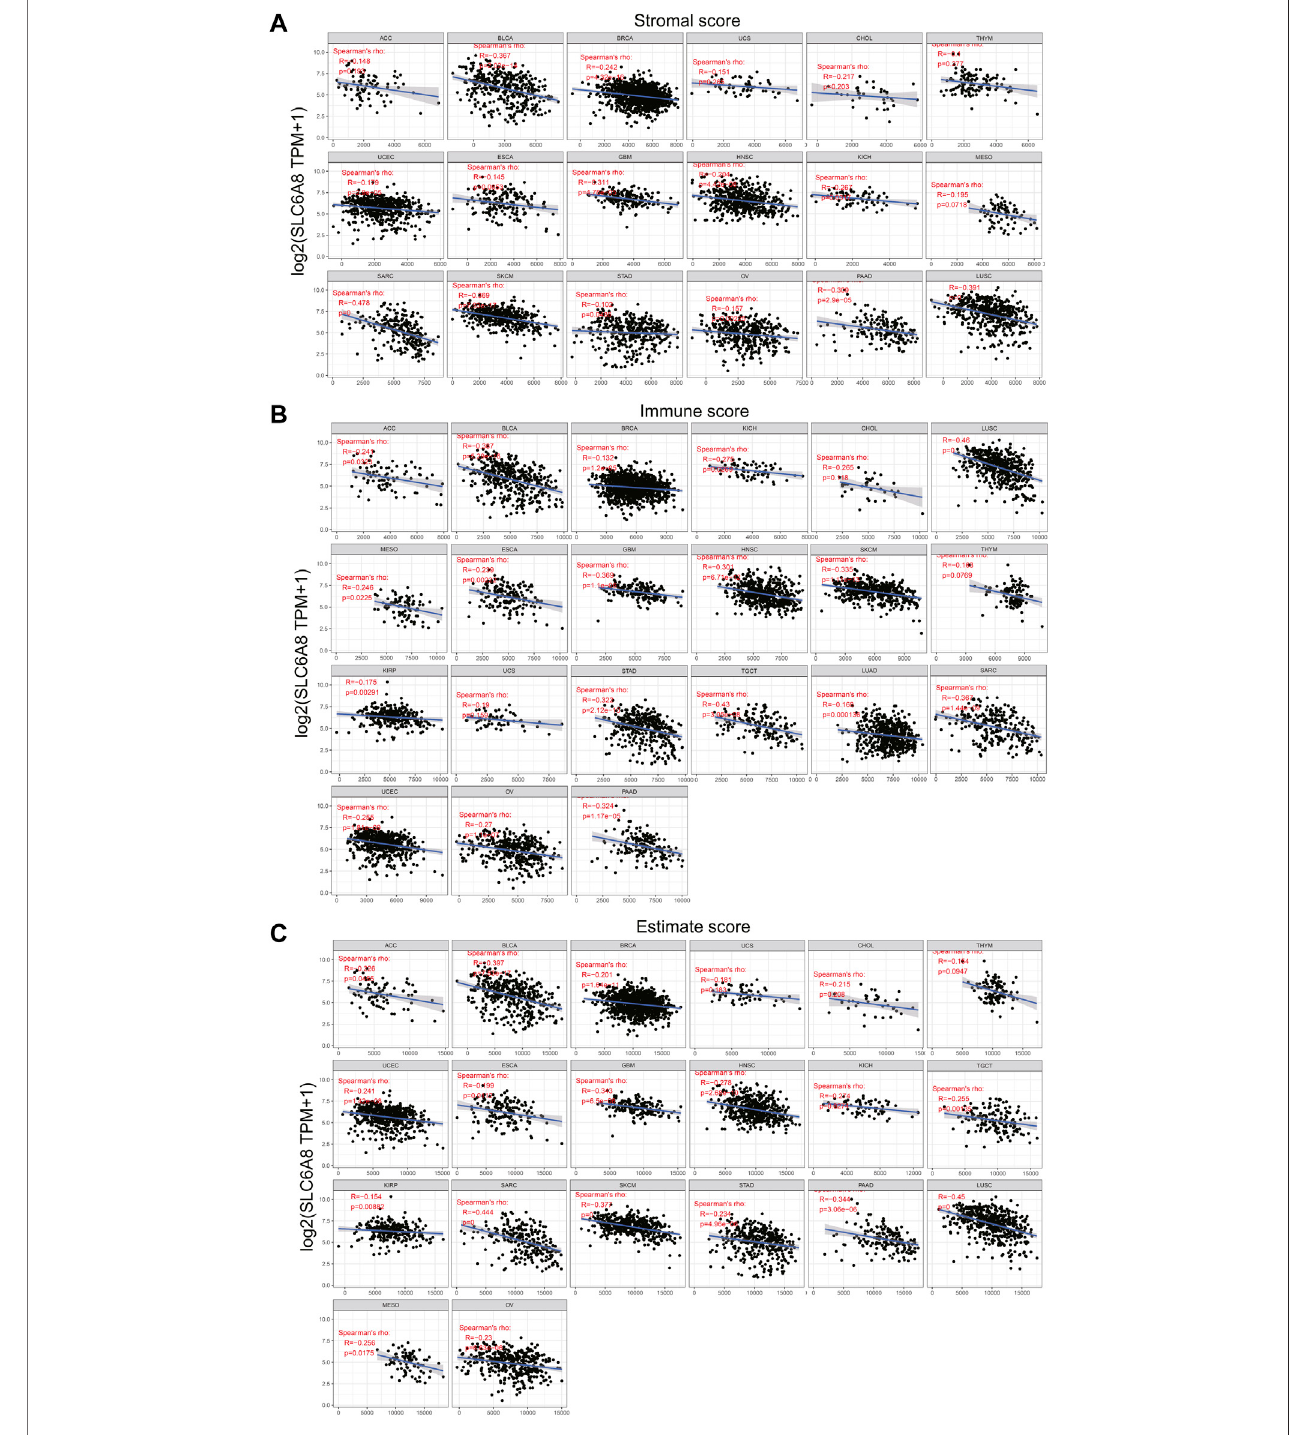
FIGURE7| SLC6A8 expressionwasassociatedwithimmuneconditions. (A) – (C) SLC6A8 expressionwasnegativelyrelatedwithimmunescore (A) ,stromalscore (B) and estimate score (C) in various cancers.